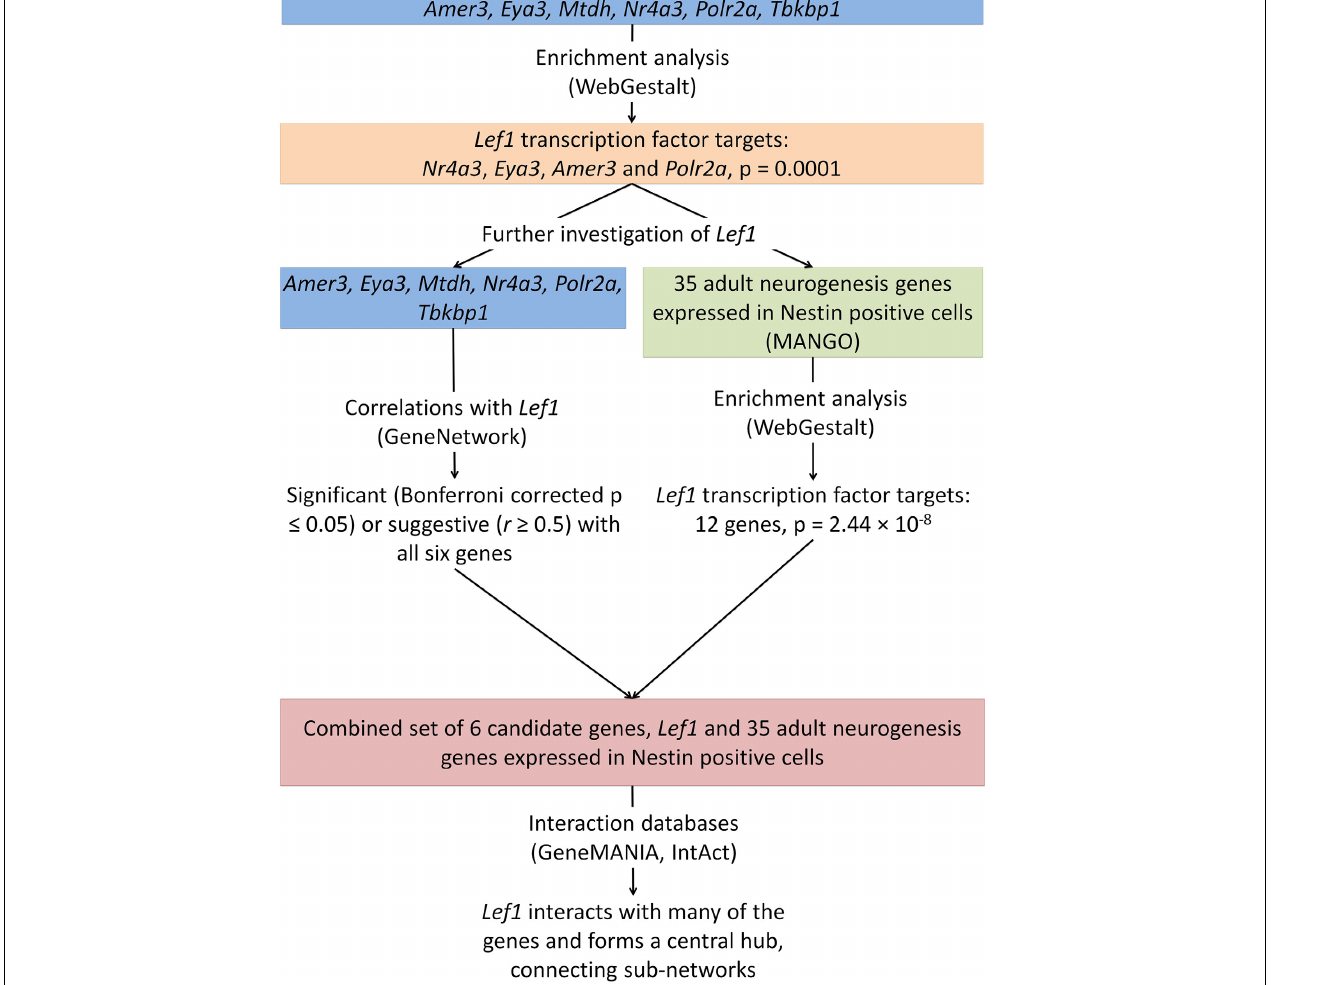
was further investigated using enrichment of genes known to be expressed in Nestin positive cells, correlation analysis between our candidate genes and Lef1 , and the use of interaction databases to find links between our